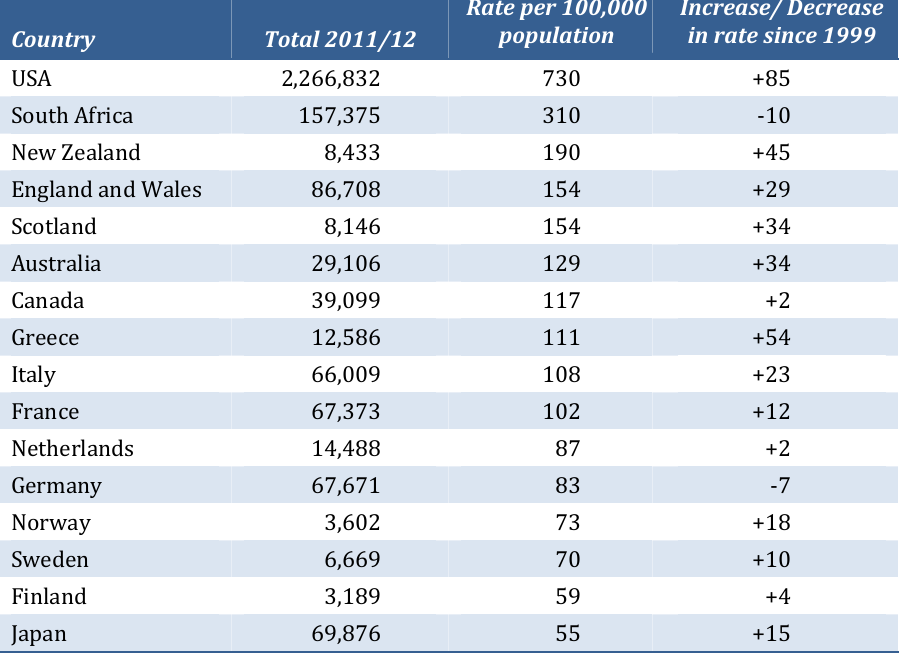
Table 1: Comparing prison populations (selected countries) Country Total 2011/12